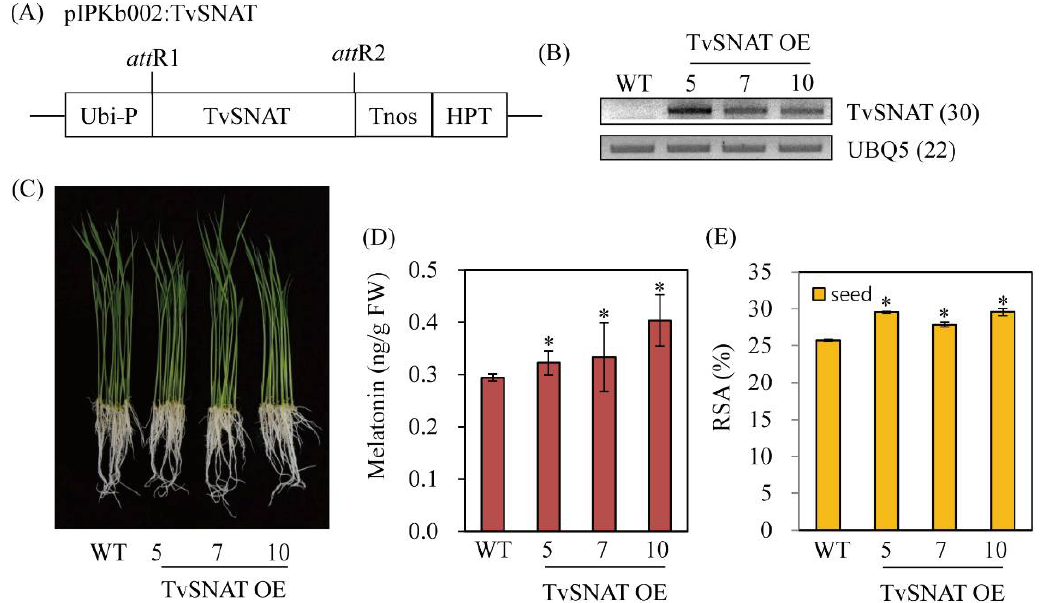
Figure 6. Schematic diagram of overexpression binary vectors, reverse-transcription polymerase chain reaction (RT-PCR) analyses, and melatonin content in transgenic rice. ( A ) Binary vector (Gen- Bank accession no. EU161568) used for TvSNAT overexpression. ( B ) RT-PCR analyses of 7-day-old transgenic and wild-type (WT) rice seedlings. ( C ) Phenotypes of 7-day-old seedlings. ( D ) Melatonin content in 7-day-old seedlings. ( E ) Radical scavenging activity assessed by 1,1-diphenyl-2-picrylhy- drazyl (DPPH) in seeds. TvSNAT , Thermoplasma volcanium serotonin N-acetyltransferase ; Ubi-P , maize ubiquitin promoter; HPT , hygromycin phosphotransferase; UBQ5 , rice ubiquitin 5 gene (GenBank accession no. Os03g13170). Numbers in parentheses indicate the numbers of PCR cycles performed. Asterisks indicate significant differences from the WT (Tukey’s honest significant difference test; p < 0.05). RSA, radical scavenging activity.